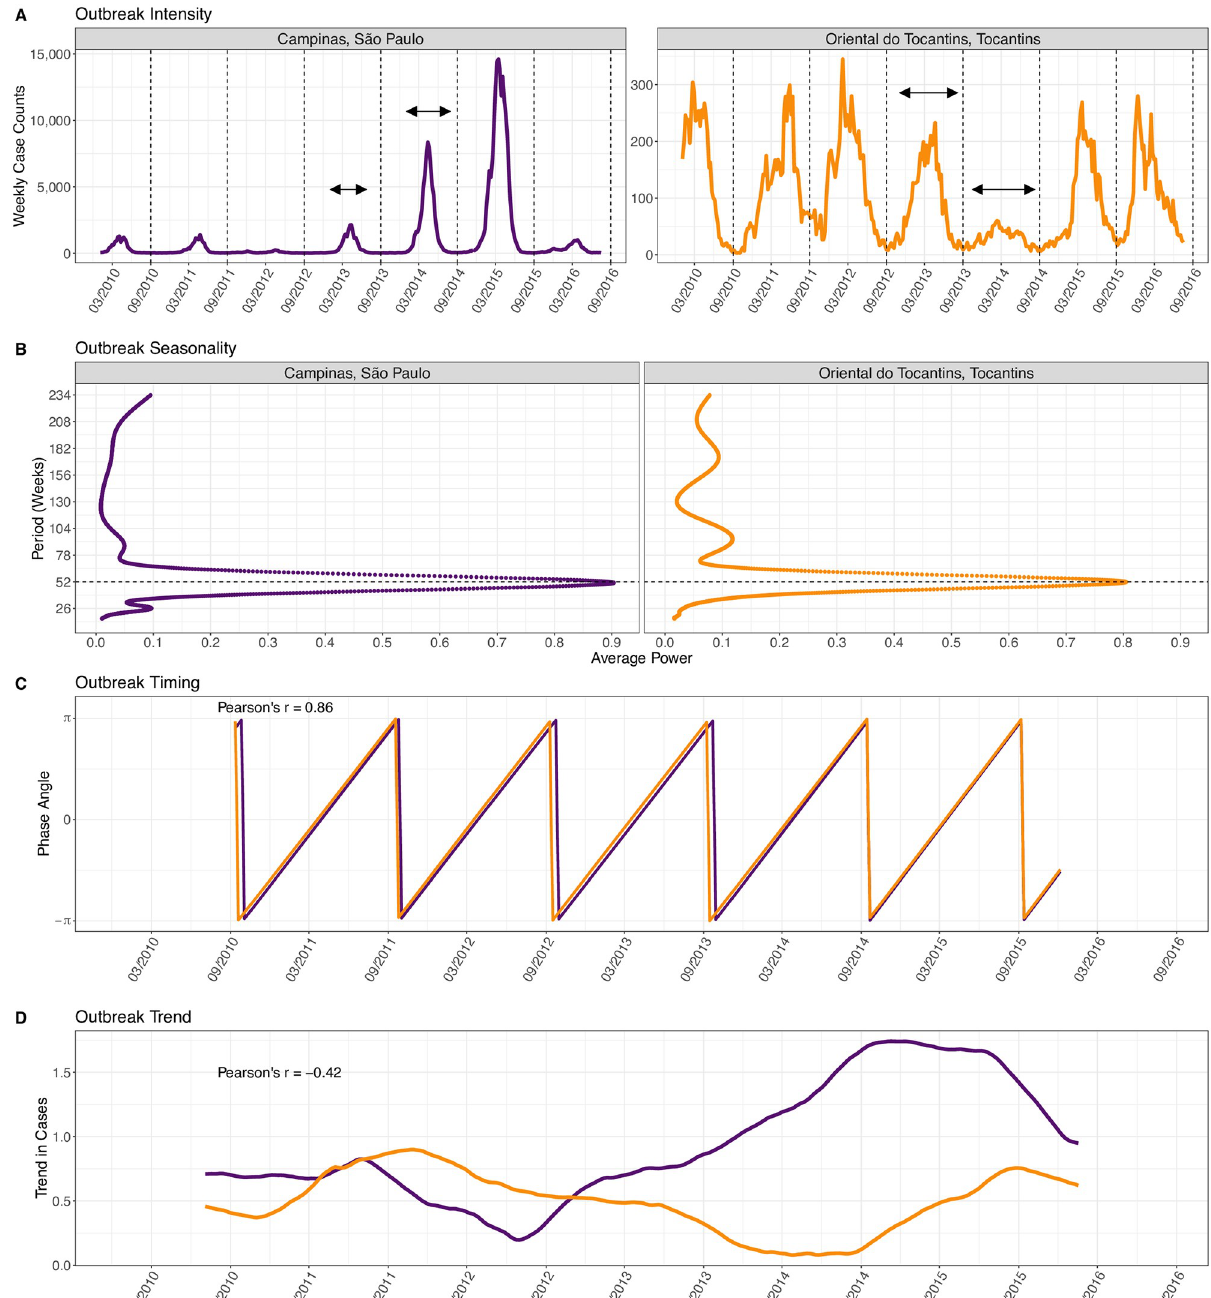
Fig 2. Outbreak properties of DENV case time series for mesoregions Campinas (S ã o Paulo, orange) and Oriental do Tocantins (Tocantins, purple). (A) Outbreak intensity , conceptually represented by the arrows, quantifies the distribution of cases over the DENV season, marked by the dashed lines. Oriental do Tocantins has a lower intensity (i.e., more equal distribution of cases) than Campinas. (B) Outbreak seasonality quantifies how well the seasonal time series fits a 52-week period. Campinas average power at the 52-week period (0.89) is higher than Oriental do Tocantins (0.81), representing a more predictable seasonal pattern. (C) The phase angles of the two mesoregions’ time series, measuring outbreak timing , are in high correlation ( r = 0.86) with each other. The average phase difference between the two indicates that Campinas is on average 1.2 weeks behind Oriental do Tocantins. (D) The trend components, measuring outbreak trend , of the two mesoregions are negatively correlated over the six years of study. The time series are scaled prior to extracting the trend component.